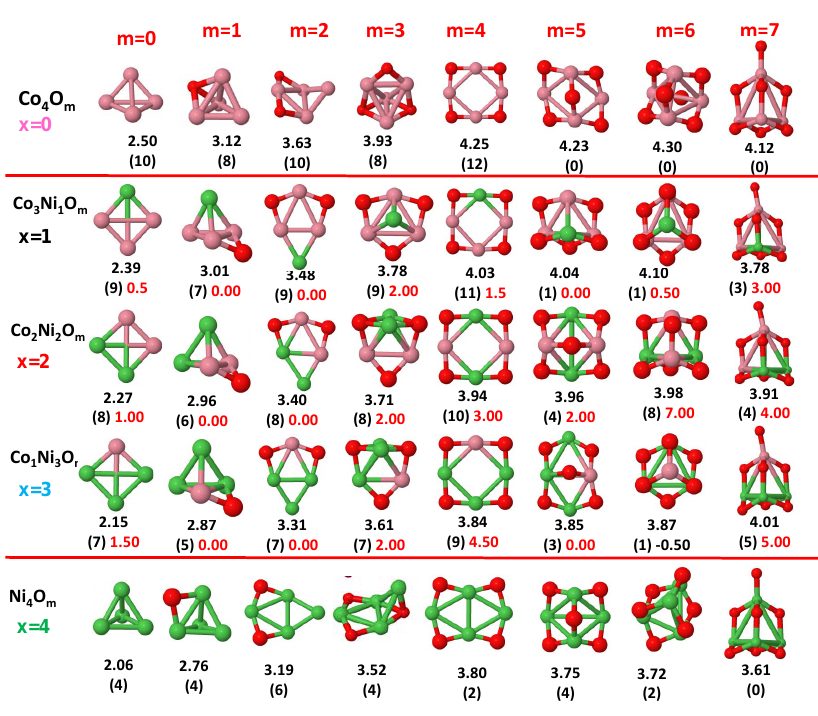
Figure 8. Putative global minimum structures of Co 4 − x Ni x O m , x = 0–2, m = 1–6. Numbers below structures are the binding energy per atom (in eV), numbers in parentheses are the magnetic moment (in µ B ) and the third number (when present) is the excess magnetic moment (in µ B ) defined in Equation (2). Co atoms in pink color, Ni atoms in green and oxygen atoms in red.